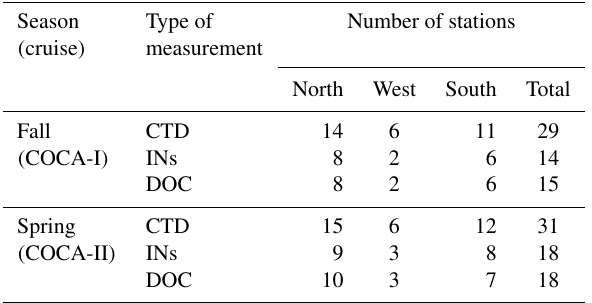
Table 1. Summary of the number and type of measurements at sta- tions per transect and